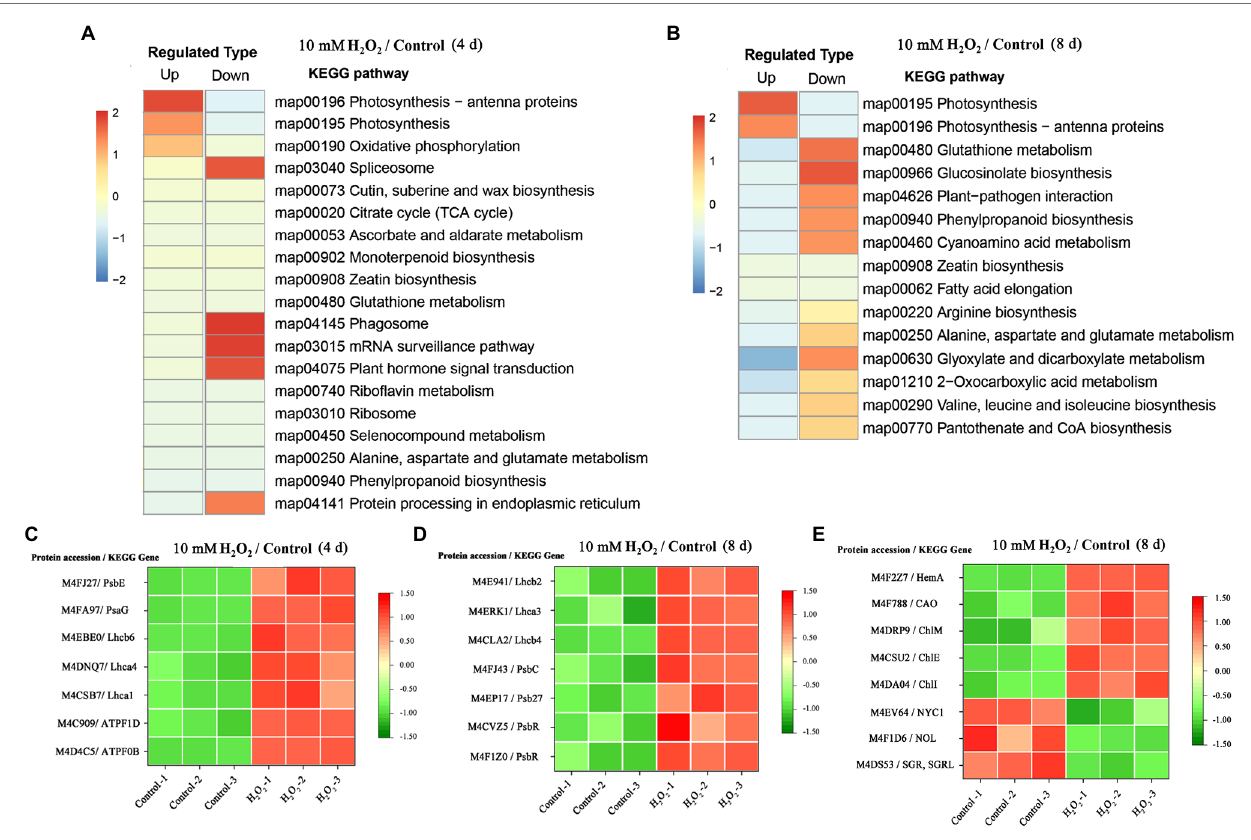
FIGURE 3 | The regulation of H 2 O 2 treatment in chlorophyll synthesis and degradation process. Enrichment of Kyoto Encyclopedia of Genes and Genomes (KEGG) pathways of upregulated proteins and downregulated proteins of Chinese flowering cabbage leaf at day 4 (A) and day 8 of storage (B) . Heat map of differentially regulated proteins involving in photosynthesis and light-harvesting during storage (C,D) ; and chlorophyll synthesis and degradation (E) at day 8 of